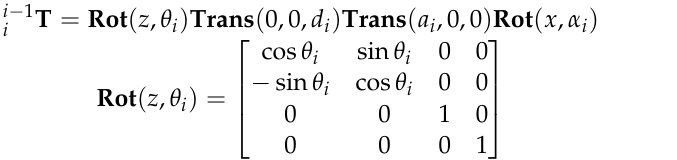
Figure 12. ( a ) The schematic structure of the UR5 robot ( b ) detailed explanation of θ i , d i , a i , and α i . The UR5 robot’s pose change matrix in the D-H model is shown in Equation (9). i − 1 i